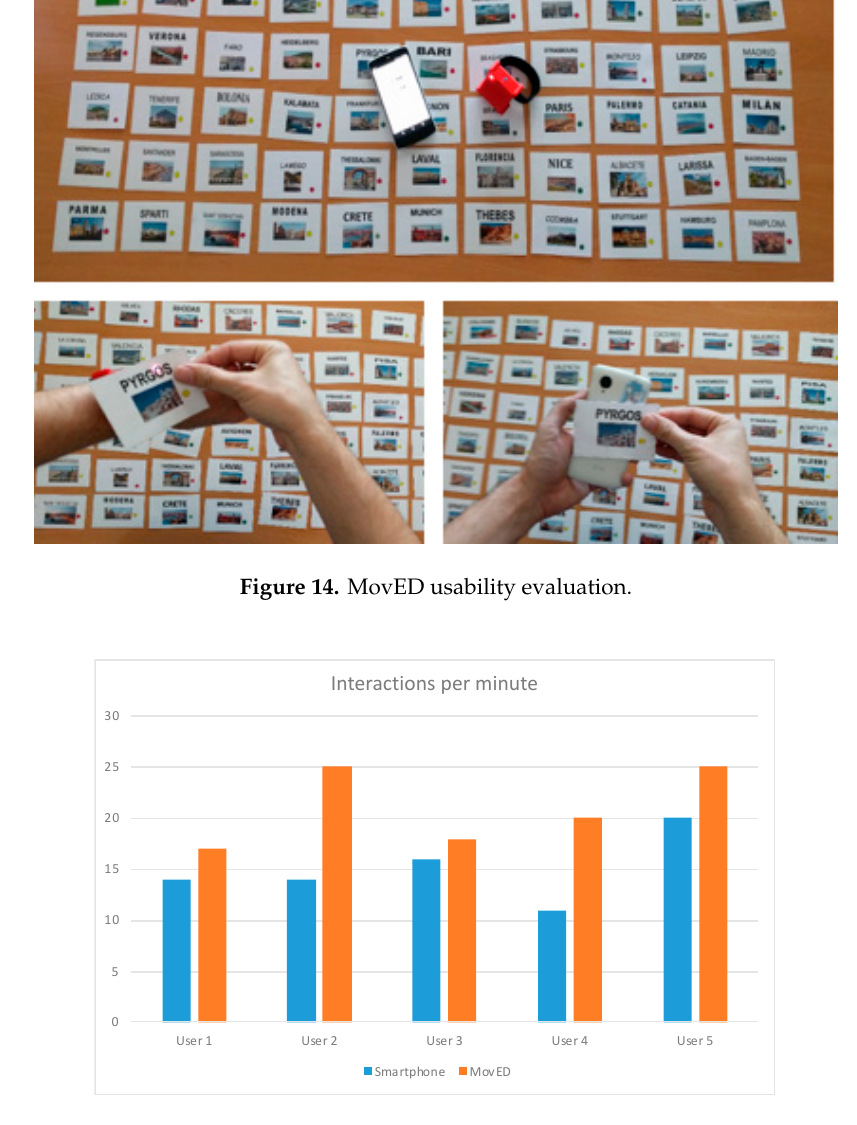
Figure 15. Interactions per minute.